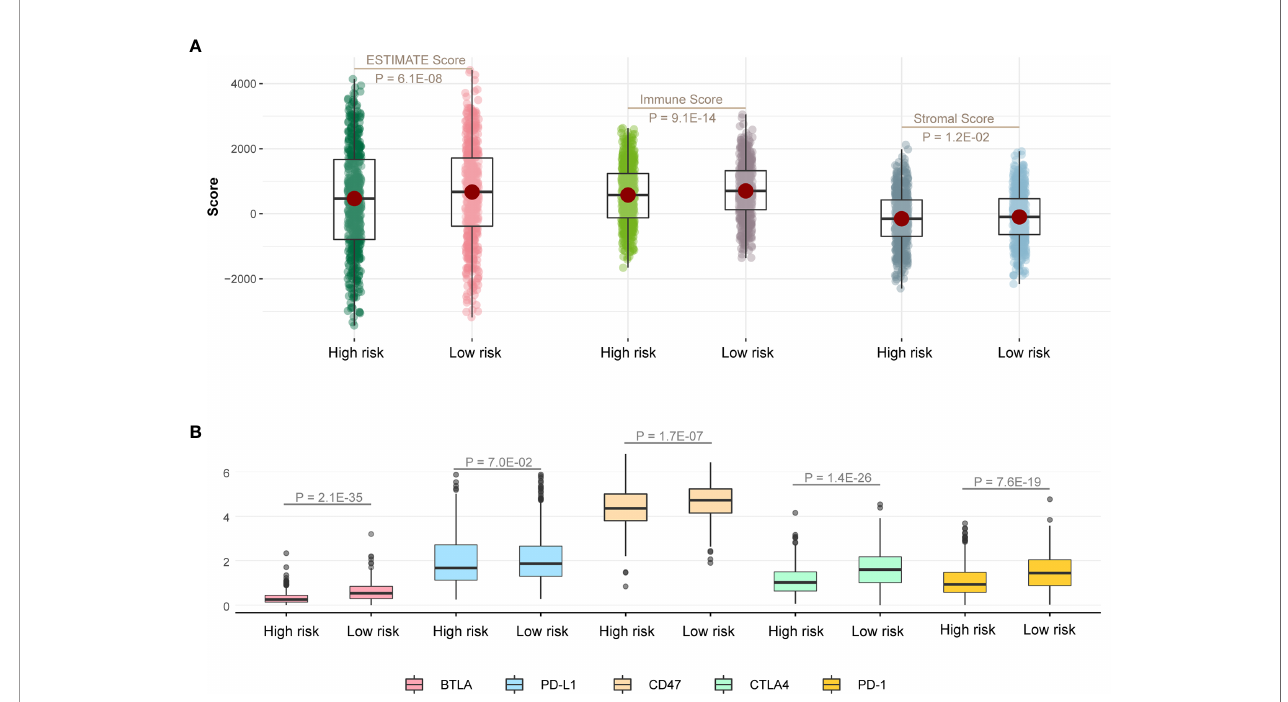
FIGURE 5 | Immune in fi ltration discrepancy in different risk groups. (A) One-sided Wilcoxon rank-sum test showed the differences of ESTIMATE scores between high- and low-risk groups in TCGA LUAD training cohort. (B) The differences in the expression of fi ve immune checkpoint related genes between high- and low-risk groups in TCGA LUAD training